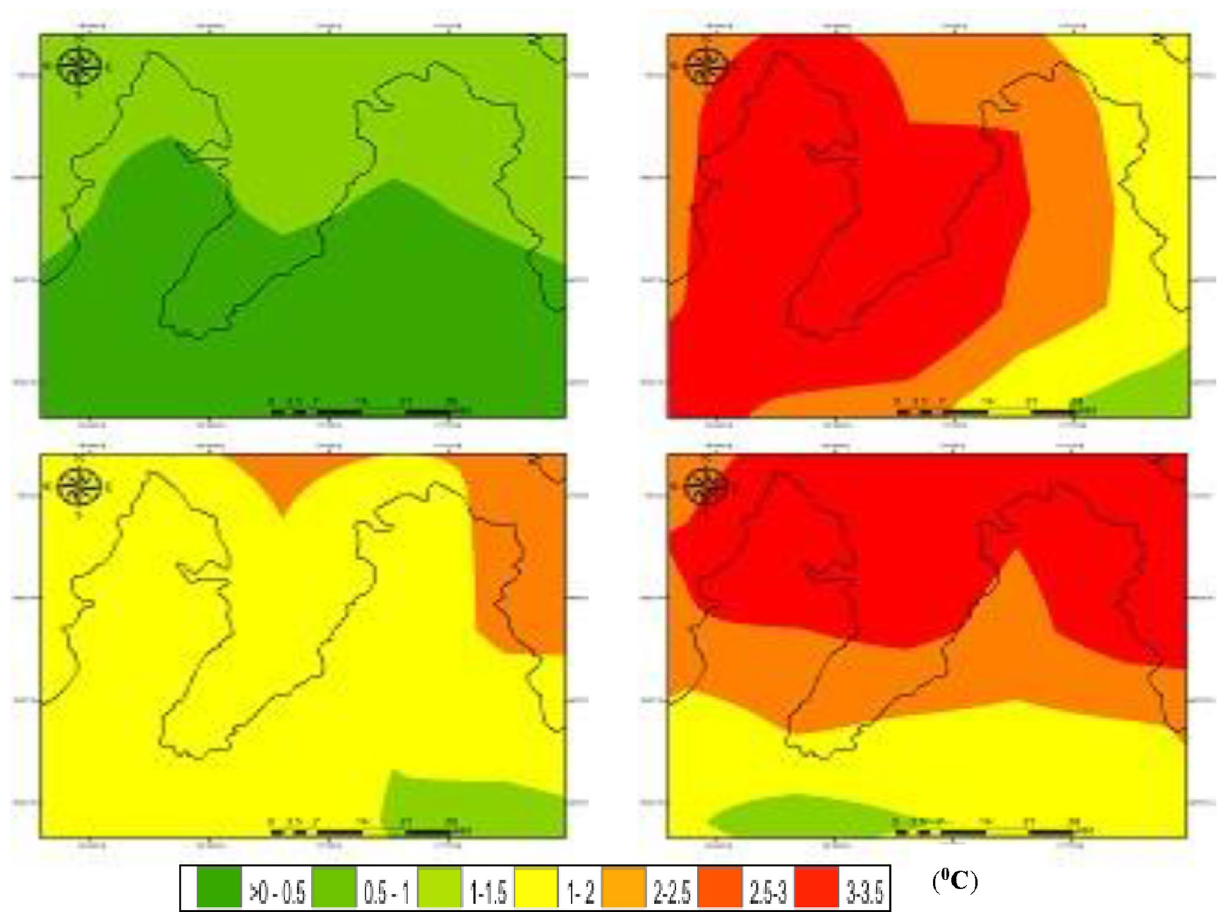
Fig. 4 Spatial changes of seasonal temperature (°C) changes for 2050 (left panel) and 2100 (right panel) to baseline (2010) during the winter (top panel) and summer (bottom panel) under RCP 8.5